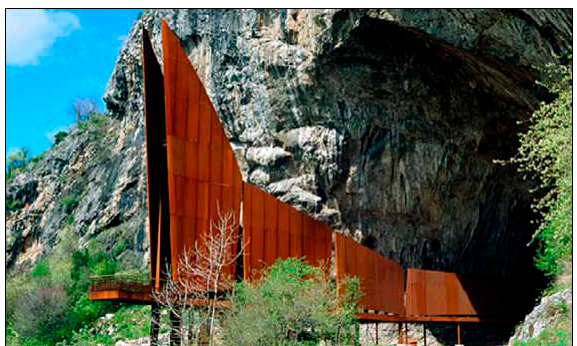
fig. 7. The Cave Painting Museum in niaux,